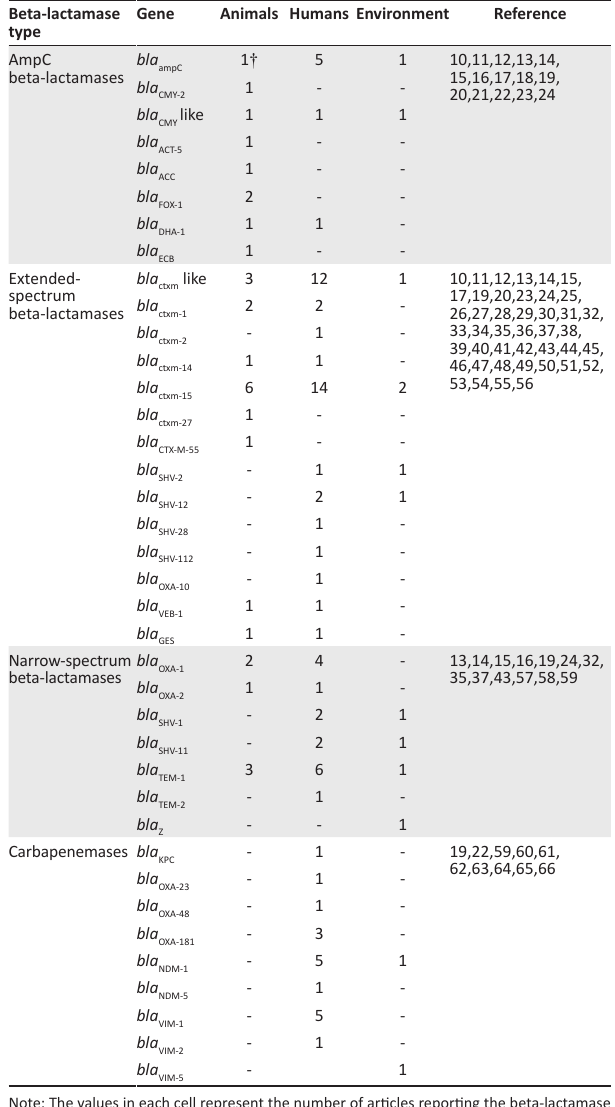
Ar(cid:29)cles: PubMed ( n = 197), AJOL ( n = 30) and Google